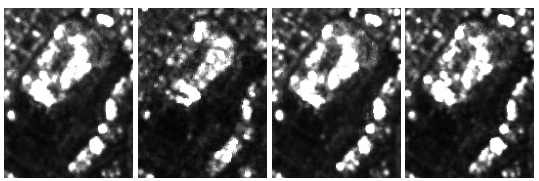
Figure 2. Temporal median images of an empty parking. Images taken from ascending and descending passes were sorted apart, as well as images taken with two different incidence angles for the ascending